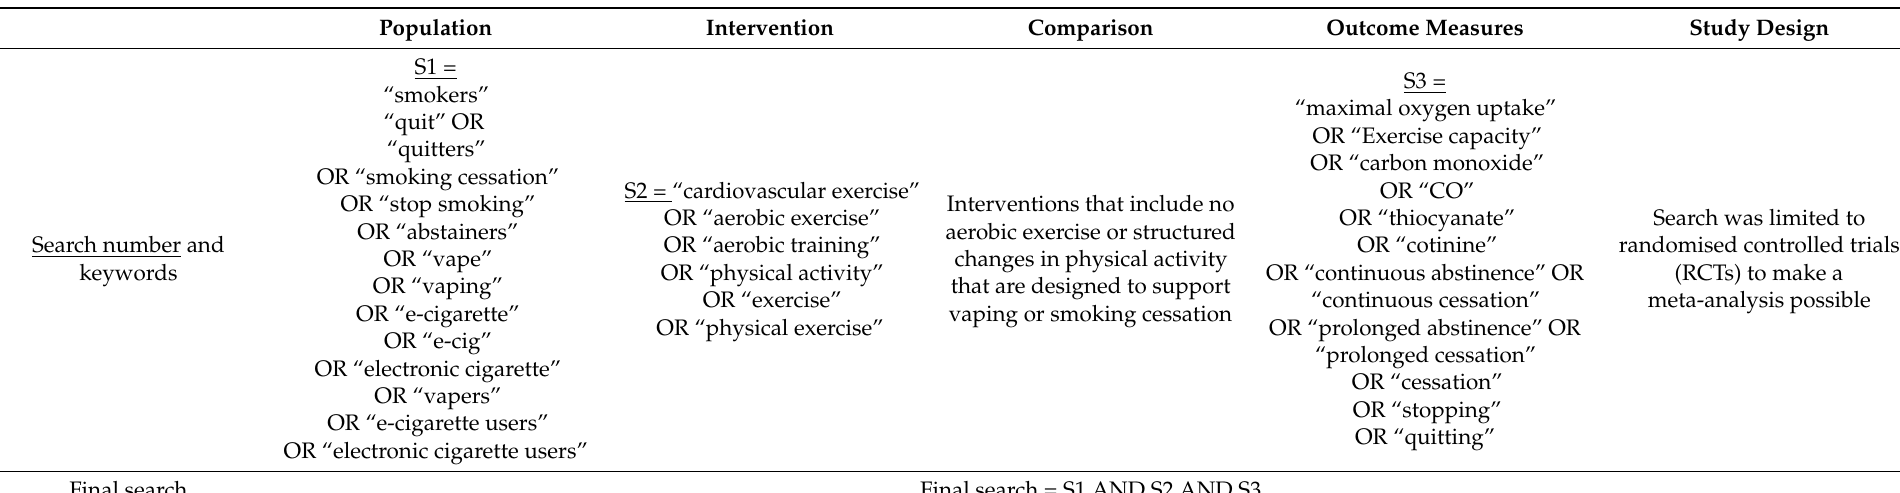
Table 1. Keywords and search strategy used, using the PICOS approach in the selected